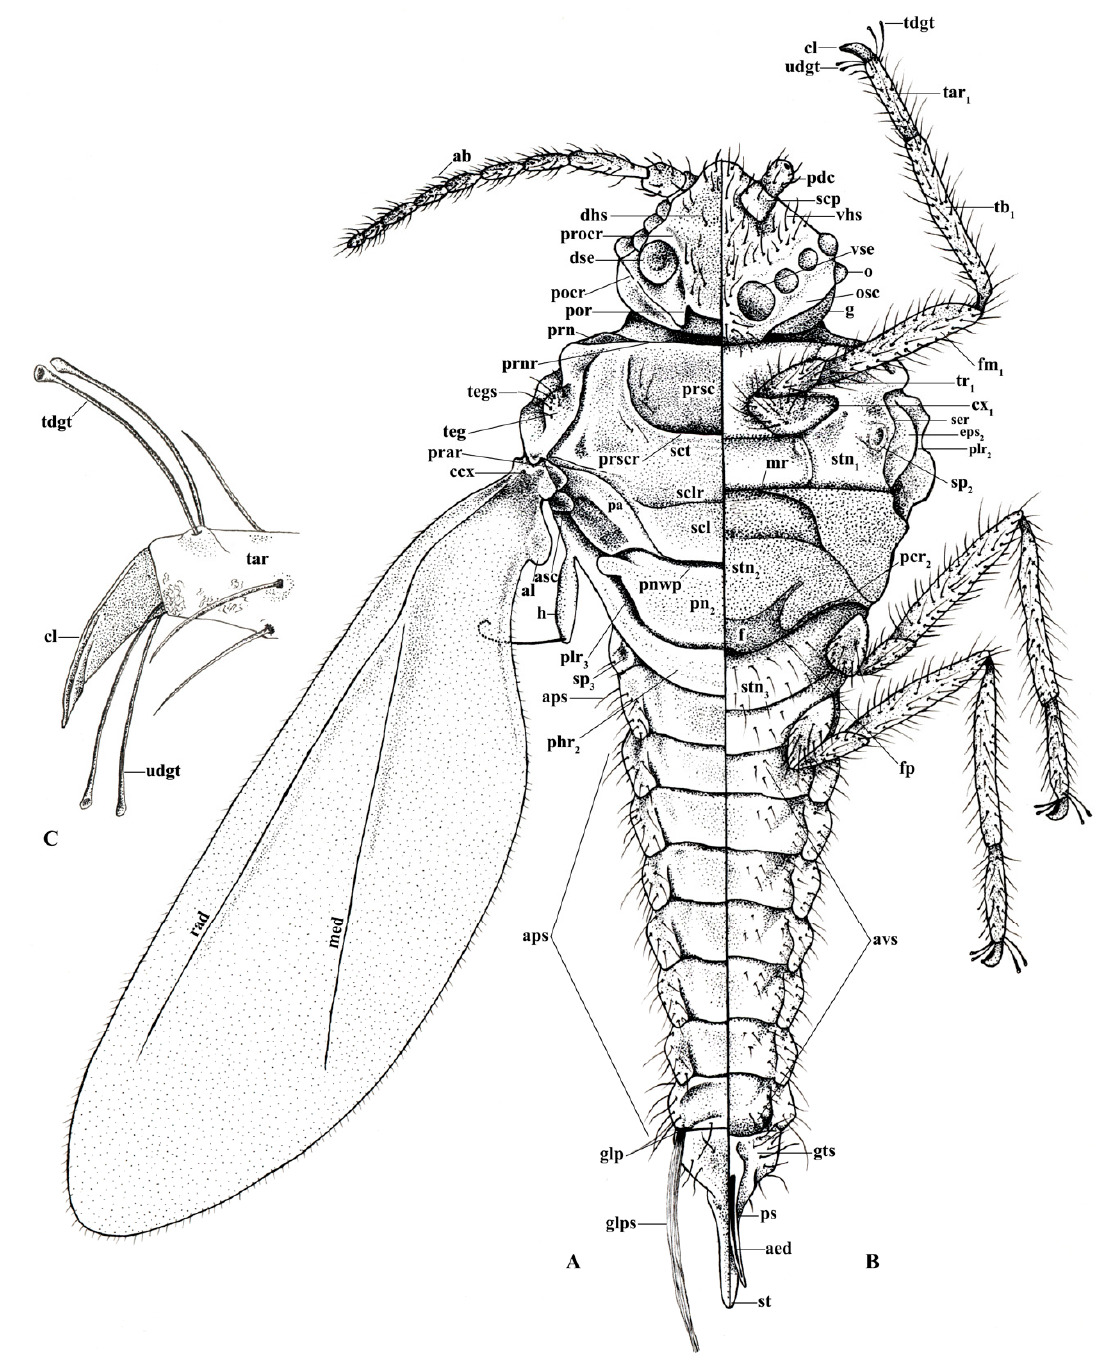
Figure 1. Illustration: ( A ) Dorsal view of Allokermes galliformis ; ( B ) Ventral view of A. galliformis ; ( C ) Claw, tarsus, and ungual digitules. Illustration by Alison L. Hall.